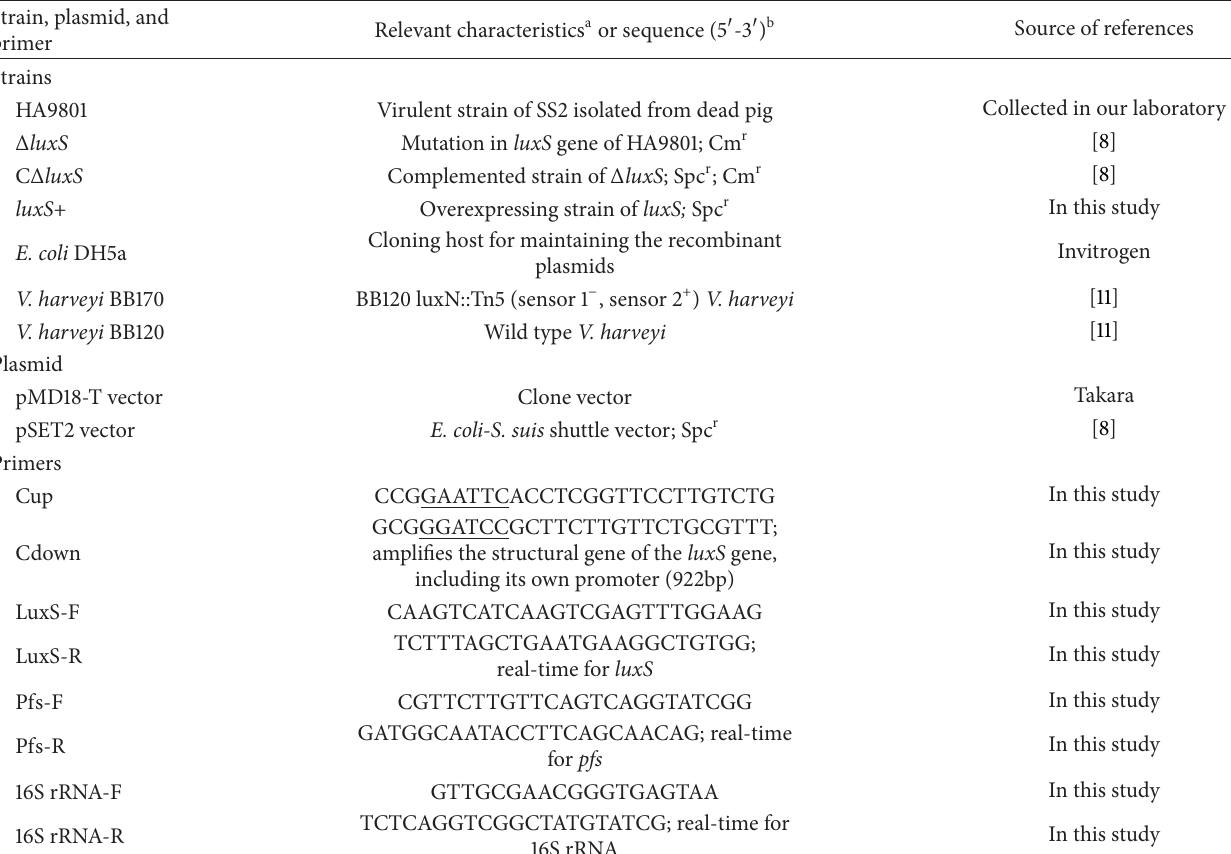
Table 1: Characteristics of bacterial strains, plasmids, and primers used in this